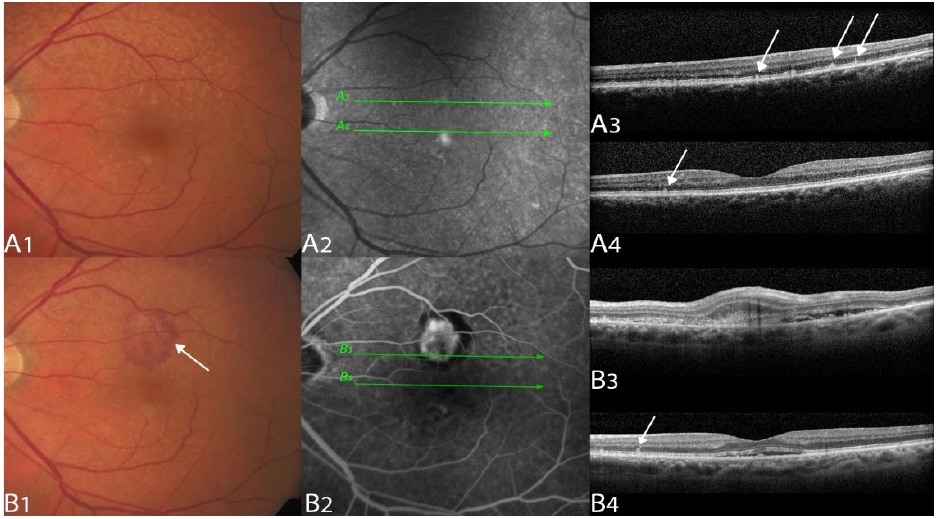
Figure 1. Multimodal imaging example of a type 2 macular neovascularization.